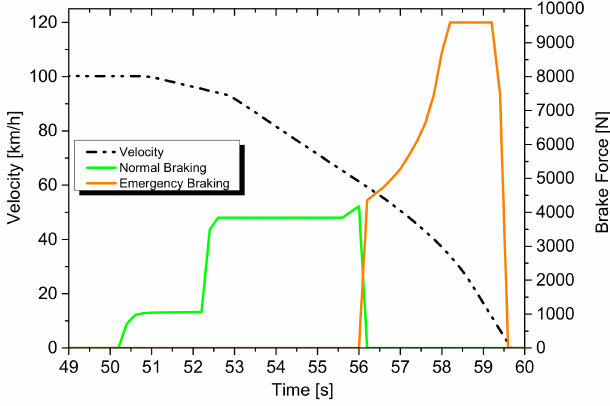
Figure 15. Braking force distribution of the straight braking test cycle.